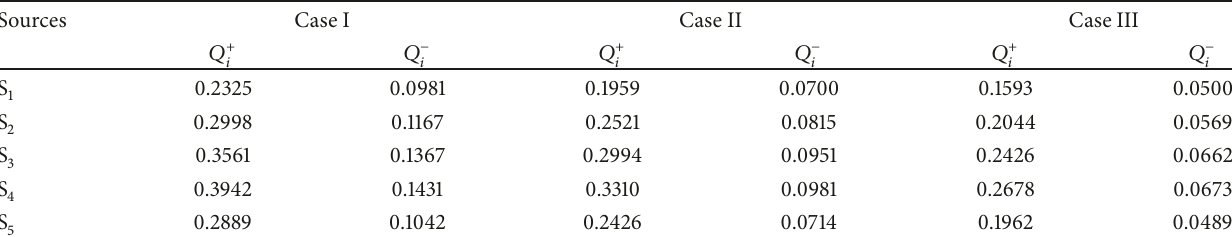
Table 23: Weighted sum and product for the cases.